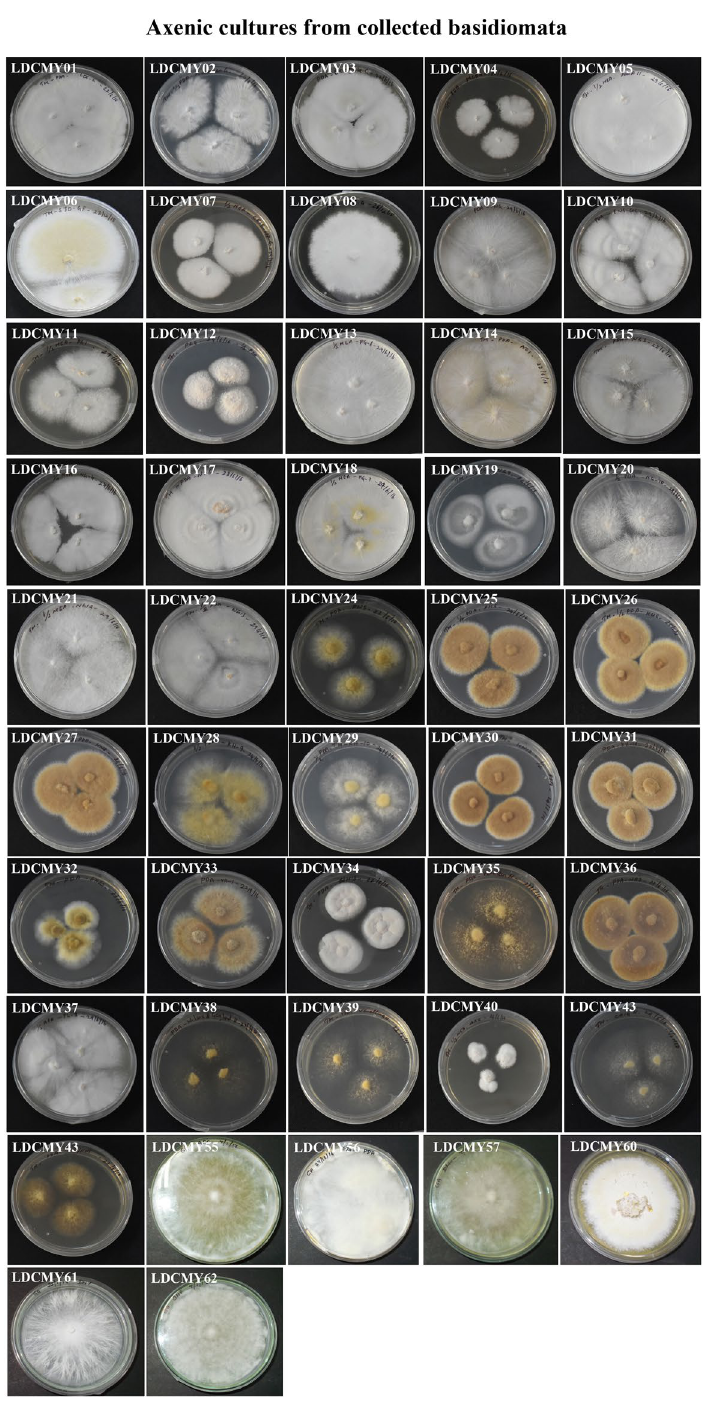
Figure 6. Axenic culture of collected basidiomata. The mycelium culture on PDA plates. Variations in growth and the color of the mycelium was observed (See Table 2). The identified strains by sequencing; Amylosporous sp . - LDCMY57 & LDCMY58; Coriolopsis caperata - LDCMY42; Fomitopsis ostreiformis - LDCMY21; Fulvifomes fastuosus - LDCMY39, LDCMY43; Ganoderma resinaceum - LDCMY01; Ganoderma sp . - LDCMY04, LDCMY05, LDCMY06; LDCMY12, LDCMY14, LDCMY16, LDCMY18, LDCMY22, LDCMY41. Ganoderma wiiroense - LDCMY19, LDCMY08, LDCMY11, LDCMY17 and LDCMY02; Inonotus rickii - LDCMY52; Phellinus badius - LDCMY36; Phellinus sp . - LDCMY23, LDCMY24, LDCMY27, LDCMY28, LDCMY29, LDCMY31, LDCMY34, LDCMY45; Trametes elegans -